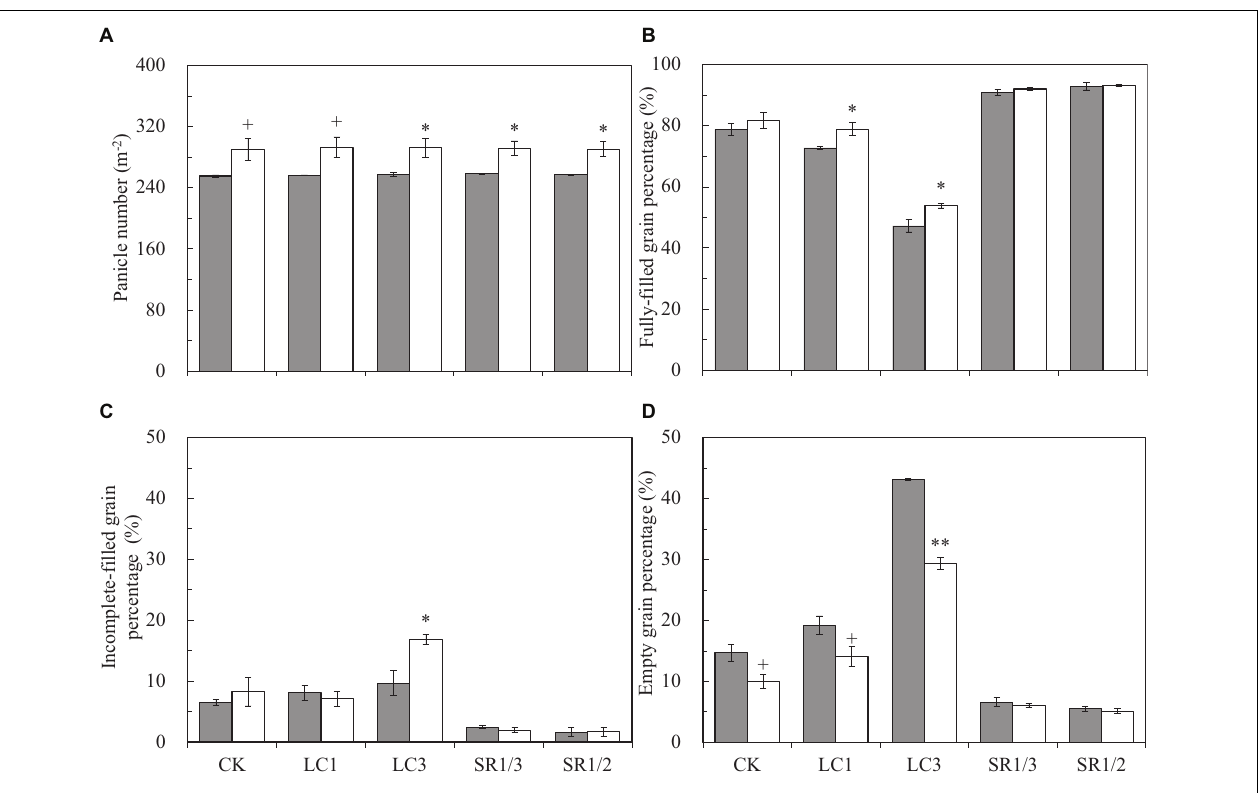
FIGURE 2 | Panicle number per area (A) , fully-filled grain percentage (B) , incomplete-filled grain percentage (C) , empty grain percentage (D) of WYJ27 affected by elevated CO 2 and different source-sink treatments in 2017. Each bar in the figure represents the mean values across three plots for ambient CO 2 (aCO 2 , filled square) or elevated CO 2 (eCO 2 , aCO 2 + 200 ppm, unfilled square); vertical bars represent standard error ( n = 3). CK, no leaf cutting or spikelet removing; LC1, cutting off the flag leaf; LC3, cutting off top three leaves; SR1/3, removing one branch in every three branches of a panicle; SR1/2, removing one branch in every two branches of a panicle. ** P < 0.01, * P < 0.05, + P <